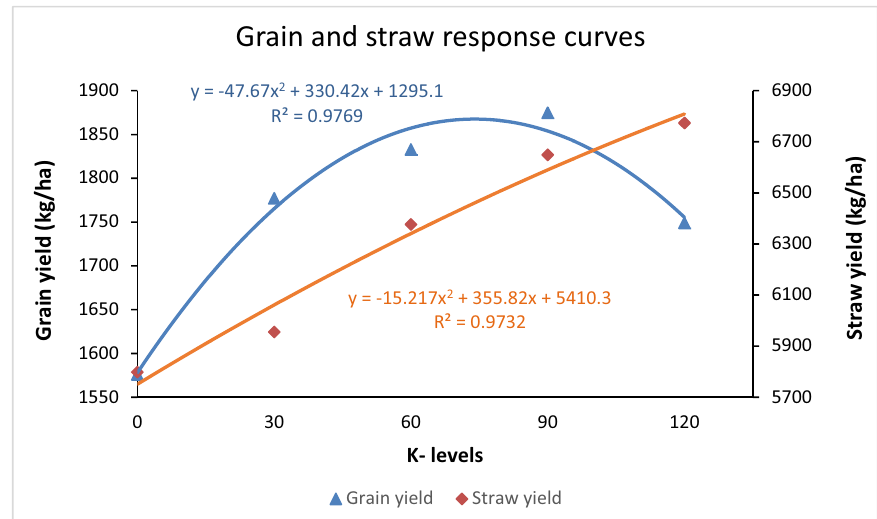
Figure 3: Te ff grain and biomass yield response to K fertilizer application combined over the location.